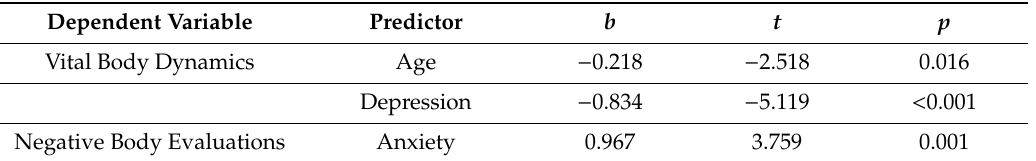
Table 4. Unstandardized regression coe ffi cients (b), t-values, and significance values (p) of the regression analyses for Vital Body Dynamics and Negative Body